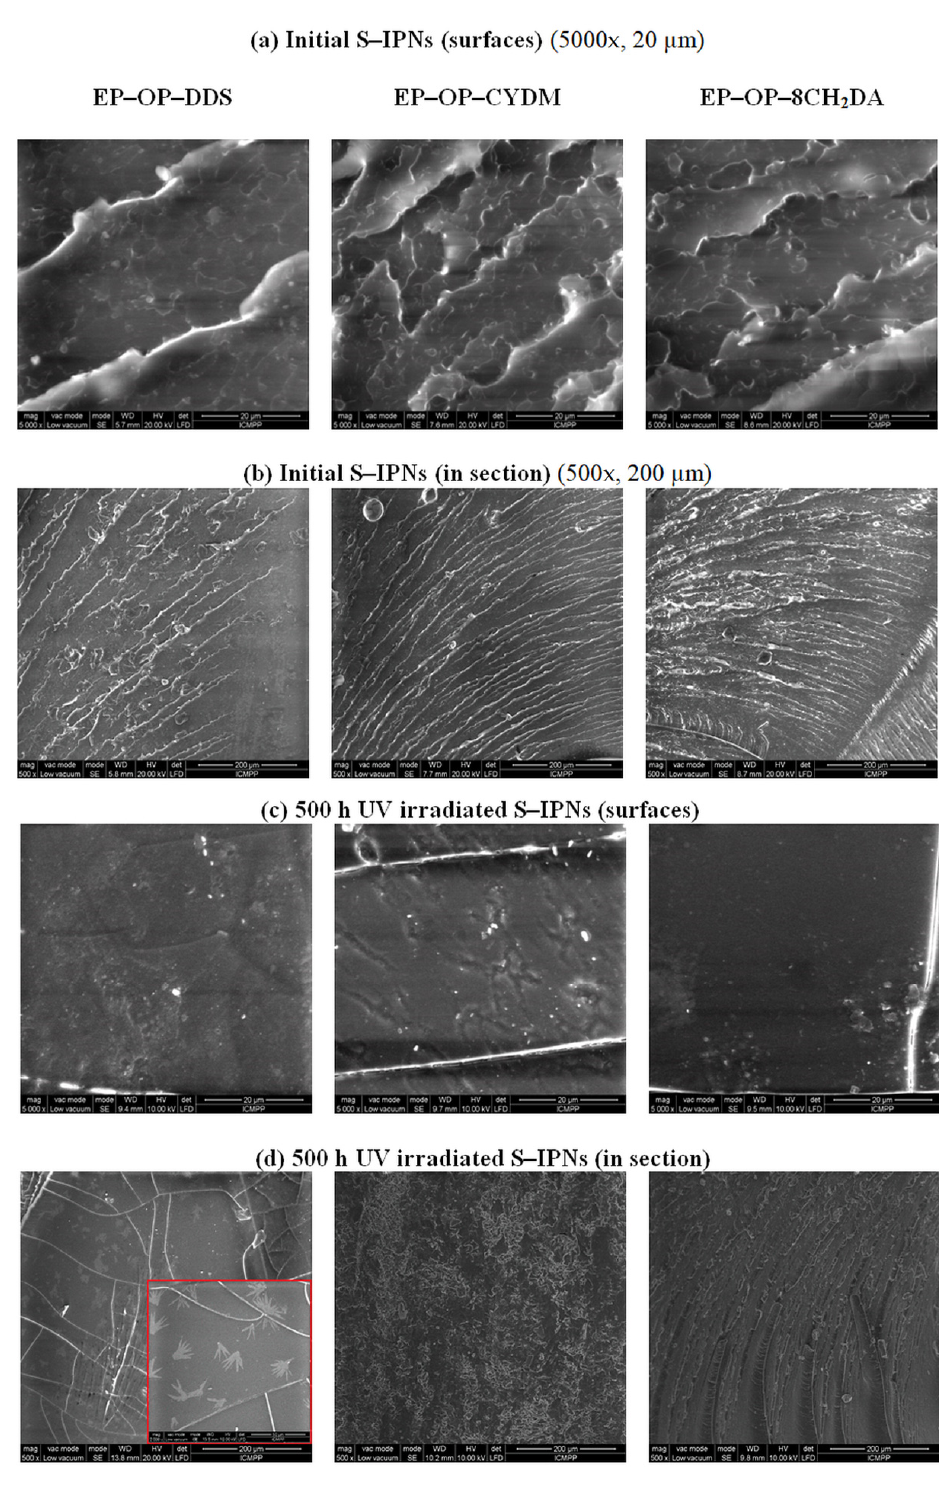
Figure 9. SEM micrographs of the S–IPNs before and after irradiation.